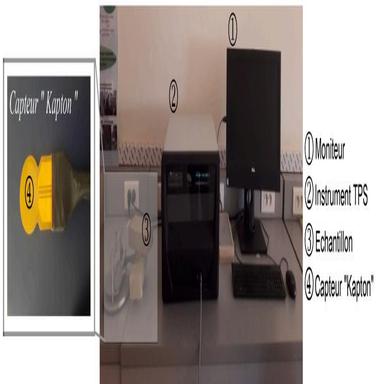
Hot disk method.